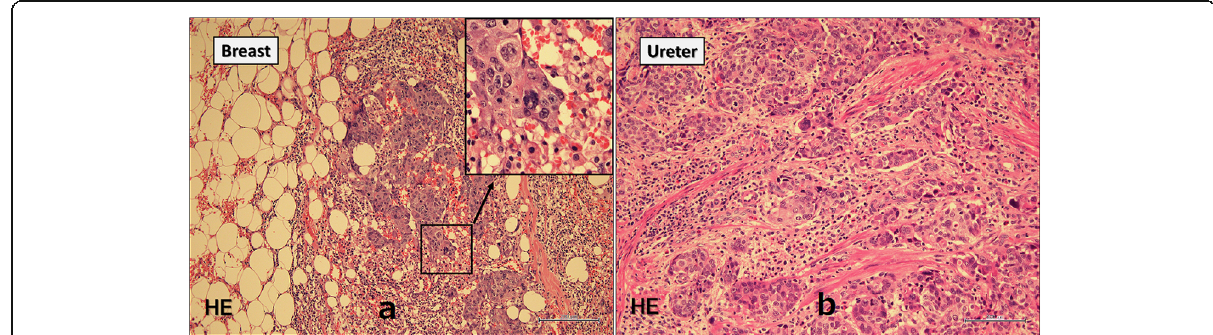
Fig. 3 Permanent pathology of the breast tumor. Legend: Tissue images showed no intraductal lesion and the border of the tumor was clear ( a ). It was very similar to that of the previous ureteral cancer ( b )